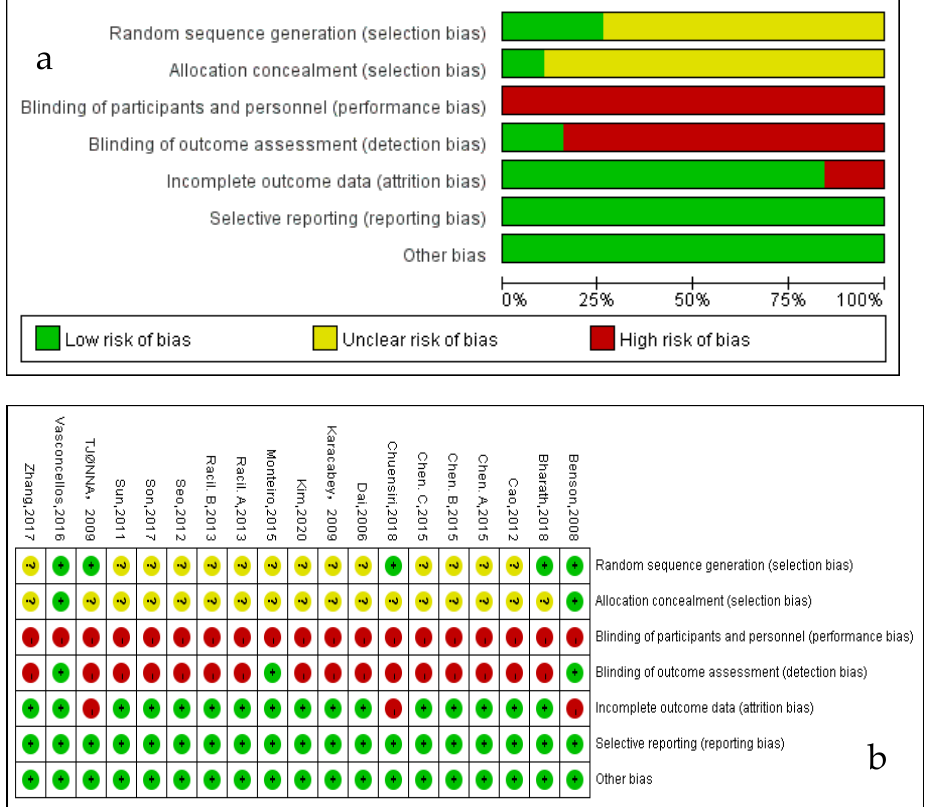
Figure 2. Risk of bias ( a ) Risk of bias graph: review authors ’ judgements about each risk of bias item presented as percentages across all included studies; ( b ) Risk of bias summary: review authors ’ judgements about each risk of bias item for each included study.